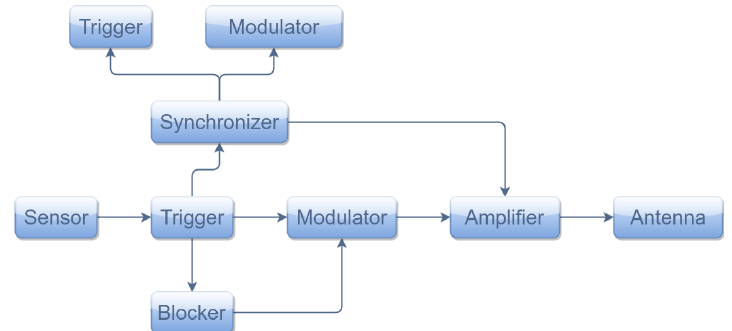
Figure 1. The principal schema of cellular radio-transmitter. The main components are: sensor —this could be a receptor that is triggered by light or neurotransmitter (serotonin); trigger —this could be a second messenger such as a ligand that could unblock the modulator and synchronizer, and the trigger should act on a blocker ; modulator —this is the array of receptors, for example ion pumps that could be synchronized via a synchronizer mechanism; amplifier —we understand it as currently coupled with a modulator or it could even be same array of receptors or ion pumps; antenna —could be DNA electrical